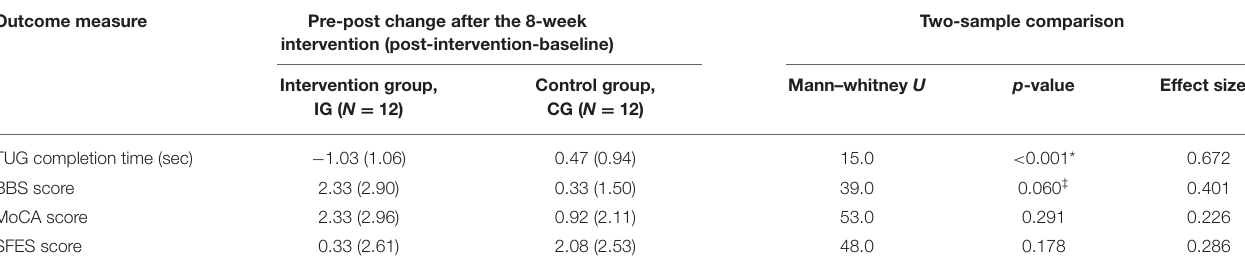
TABLE 5 | Comparison of pre-post changes in outcome measures between intervention and control groups (mean, standard deviation in bracket) after the 8-week intervention. Outcome measure Pre-post change after the 8-week Two-sample comparison intervention (post-intervention-baseline) Intervention group, Control group, Mann–whitney U p -value Effect size IG ( N = 12) CG ( N = 12)